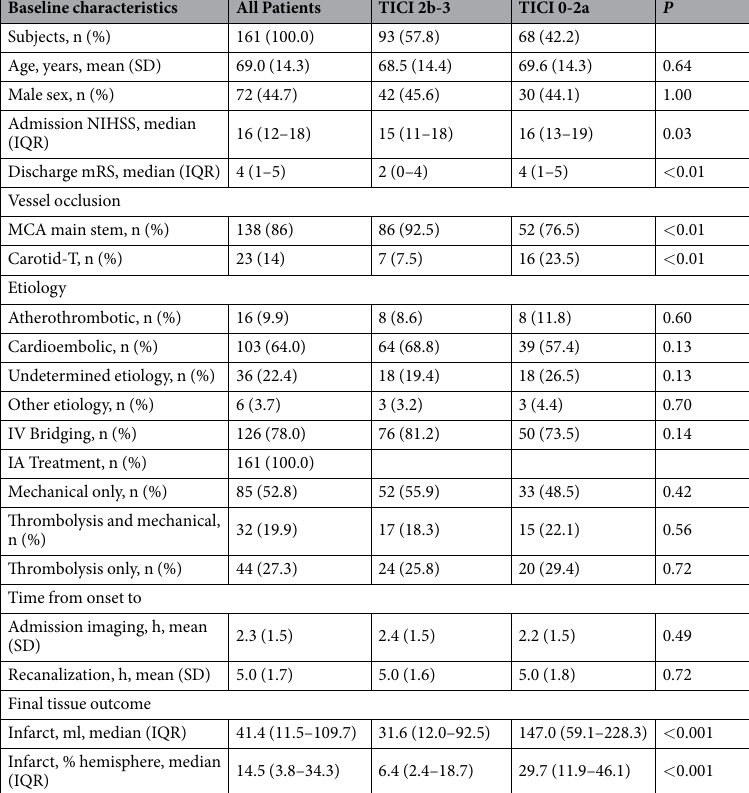
Table 1. Patient characteristic table, as previously published 13 .